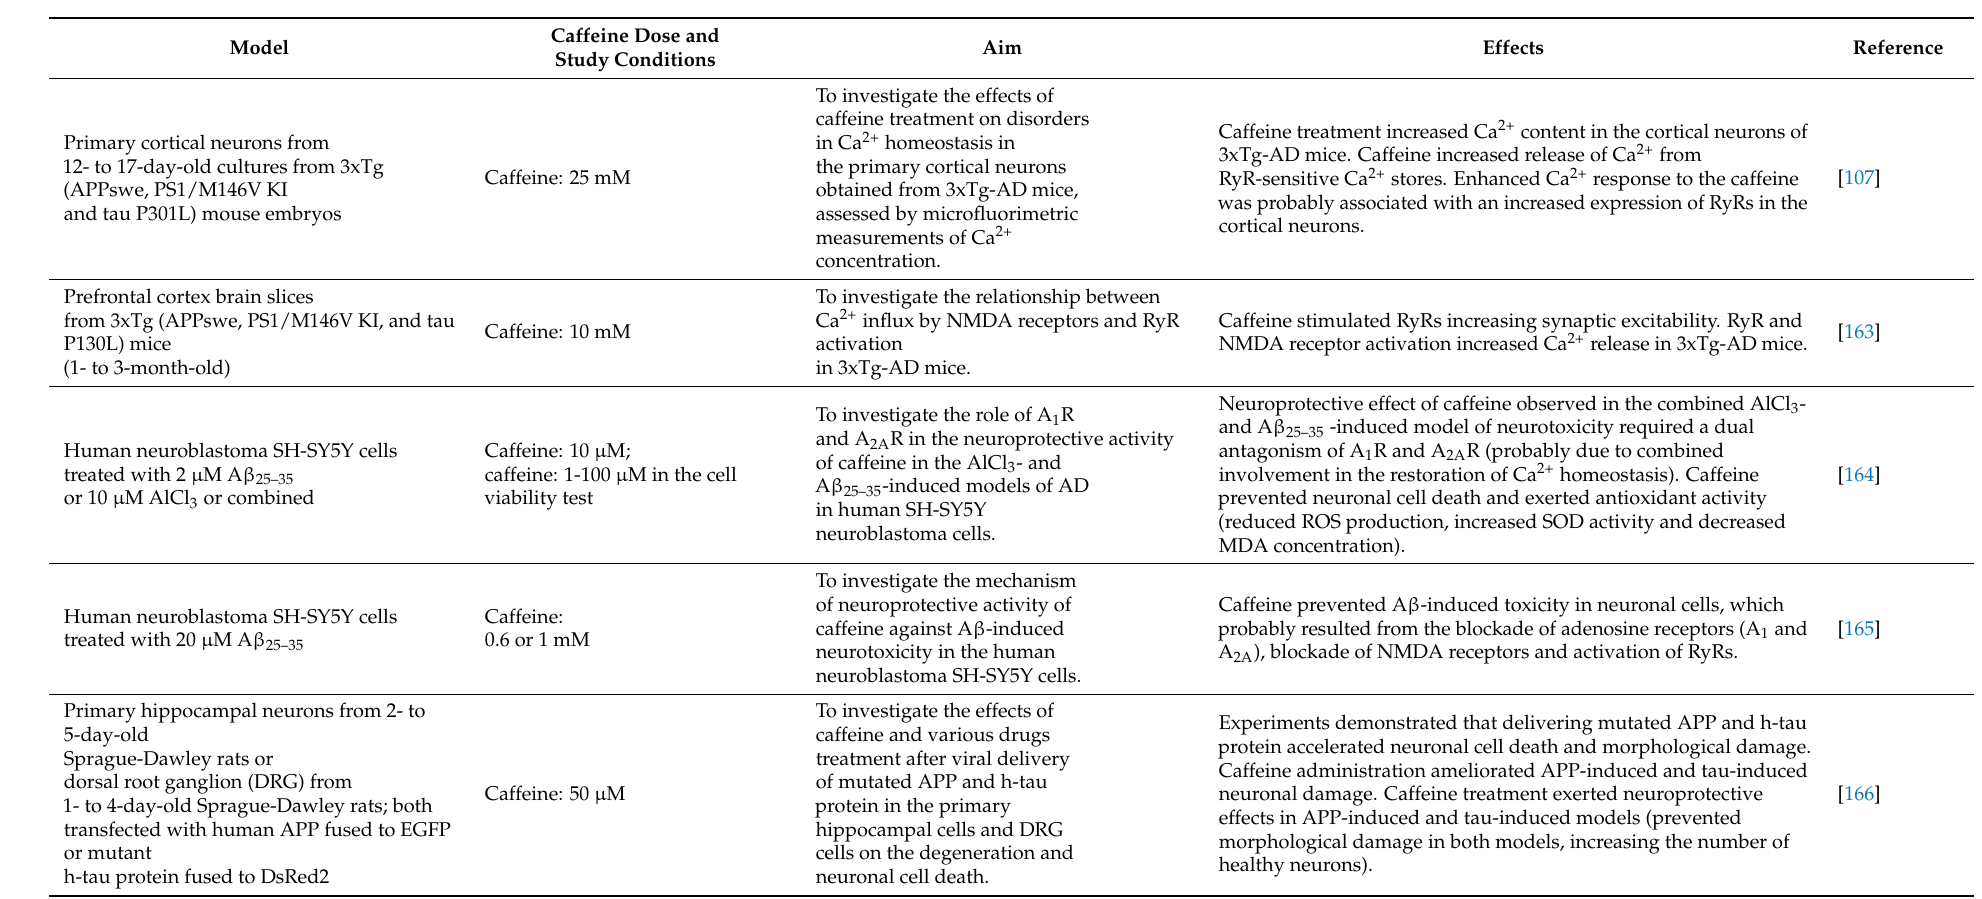
Table 5. In vitro